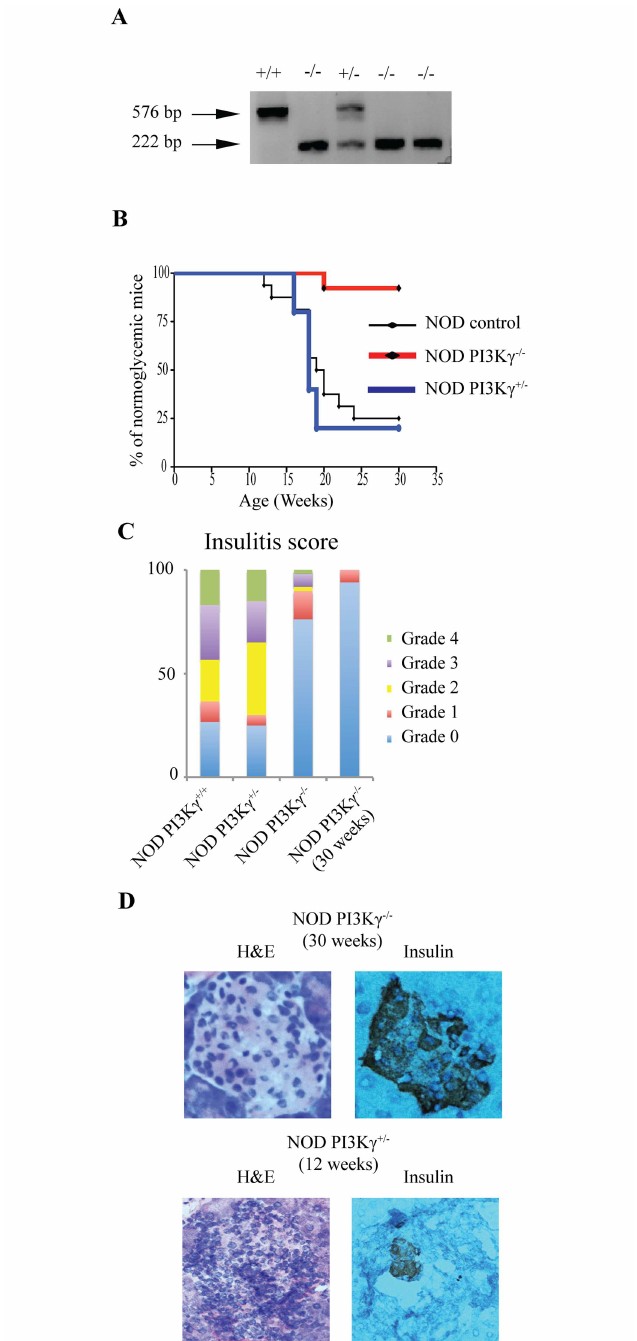
Fig 1. PI3K γ -deficiency protects NOD-mice from diabetes. (A) PCR bandsof WT NOD.PI3K γ +/+ (576 bp), homozygous NOD.PI3K γ -/- (222 bp) and heterozygous NOD.PI3K γ -/+ (222 bp and 576 bp). (B) Female NOD. PI3K γ -/- , their heterozygous-NOD.PI3K γ +/- and WT-NOD.PI3K γ +/+ littermates were followedfor diabetesfor 30-weeks. Graph represents the percentage of mice developingdiabetes overtime. (C) Insulitis score at 12-weeksof age measuredon 30 different islets from 4 mice per group is presented in the panel 1C. Mice from the above cross were sacrificedfor histopathologicalanalysisof the pancreas at age of 12-weeks. grade 0, normalislets; grade 1, mild mononuclear infiltration( < 25%)at the periphery;grade 2, 25–50%of the islets infiltrated;grade 3, > 50% of the islets infiltrated; grade 4, islets completelyinfiltrated with no residual parenchyma remaining. (D) Representative exampleof pancreatichistology(H&E and insulinstaining)from NOD.PI3K γ +/- at 12-weeksand NOD.PI3K γ -/- at 30-weeksof